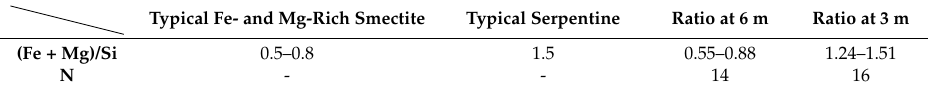
Table 2. (Fe + Mg)/Si ratios of typical Fe- and Mg-rich smectite, typical serpentine, smectite from DH4 at 6 m and minerals in the matrix of the clastic sediments from DH4 at 3 m. N represents the number of points analyzed.